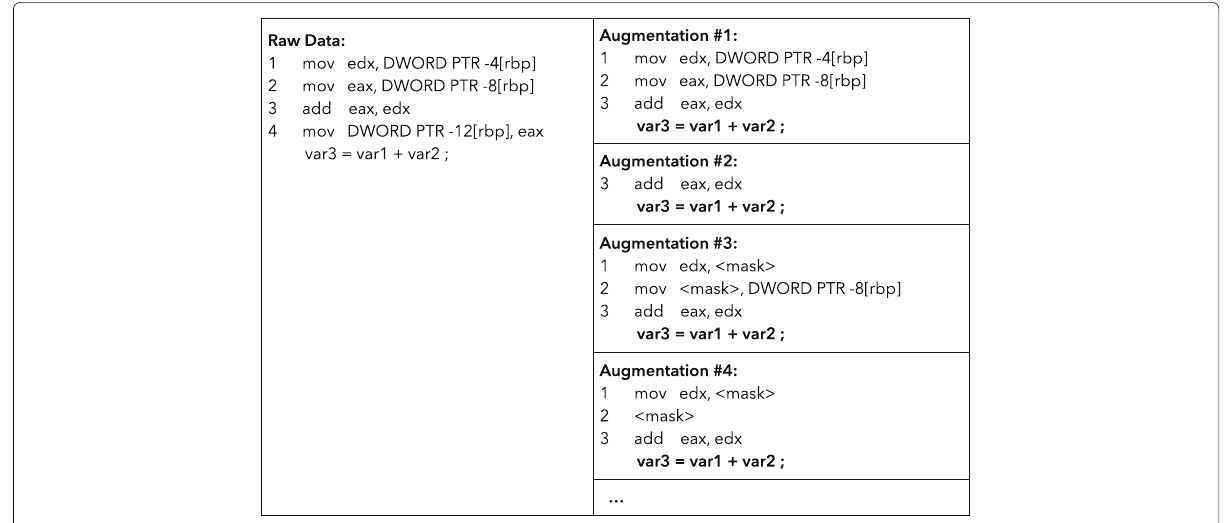
Fig. 3 An example of training data augmentation nation of several basic operations. Listing 2 is the code fragment of the expression var 4 = ( var 1 + var 2 ) * var 3 . After fine-grained segmentation, the output label is seen as <0,0,1,0,1,1> , which is obviously divided into three basic operations. Each basic operation would be used as the input of the translation model.